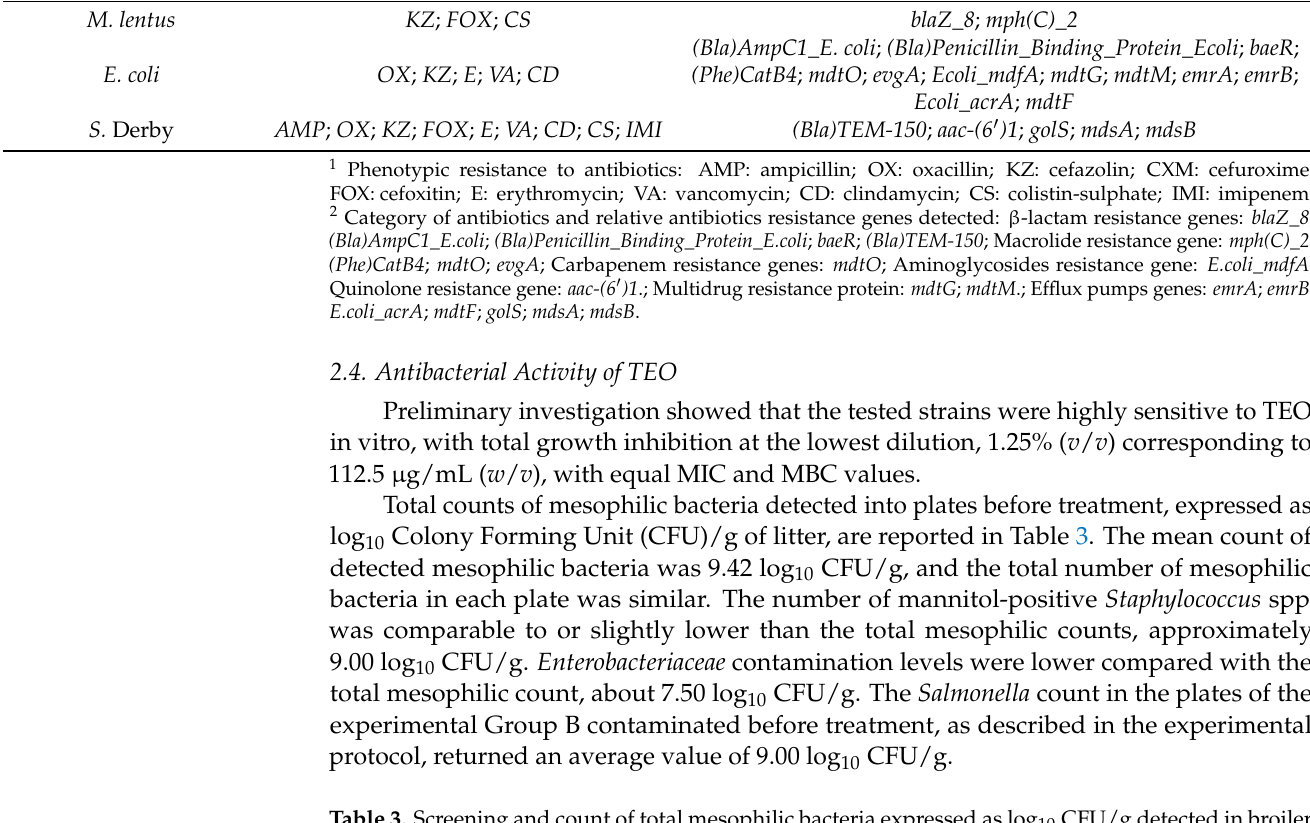
Table 3. Screening and count of total mesophilic bacteria expressed as log 10 CFU/g detected in broiler litter before treatment with